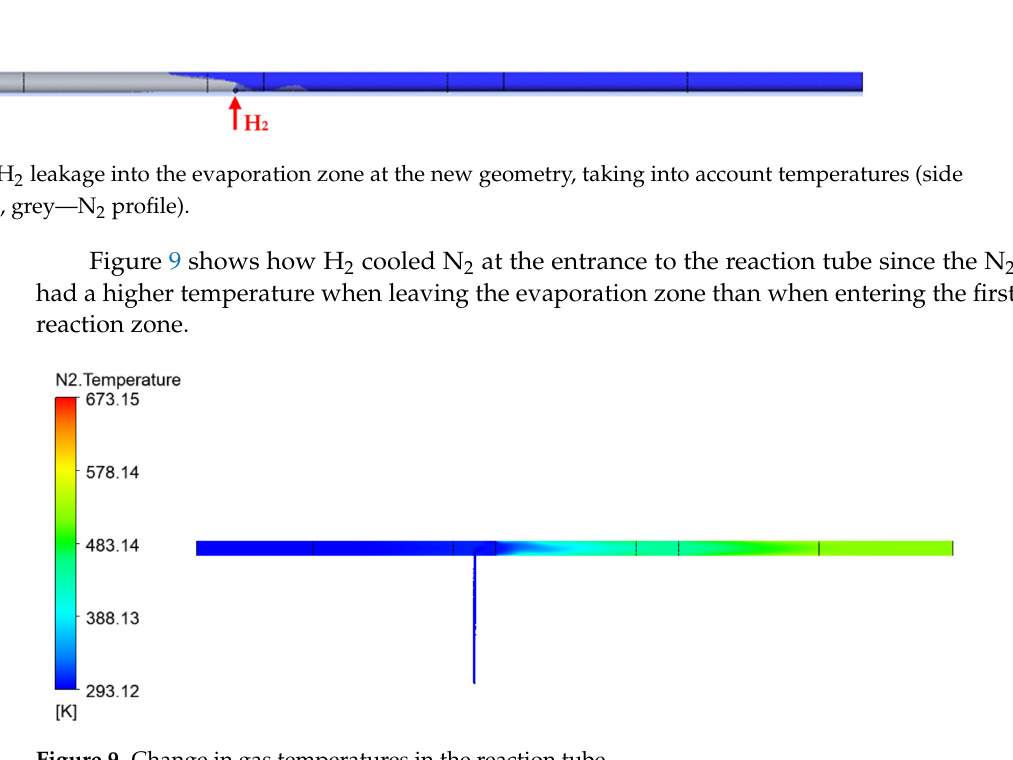
Figure 9. Change in gas temperatures in the reaction tube.